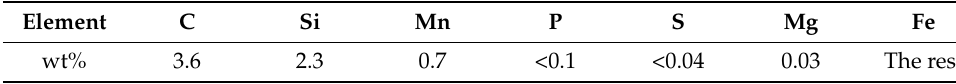
Table 1. The main composition of the